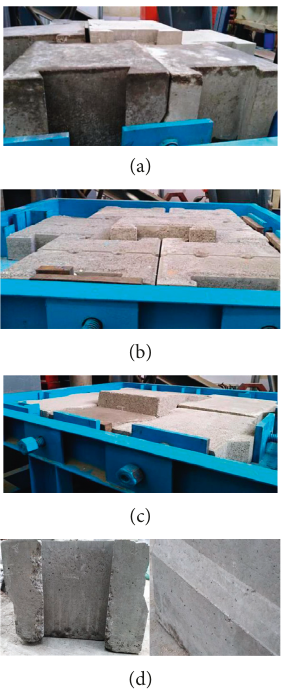
Figure 11: Variations in the surface layers of three kinds of blocks and damage of a single block. (a) Change of H-type block. (b) Change of traditional block 1. (c) Change of traditional block 2. (d) Failure of H-type gravity mutual steel slag core block.